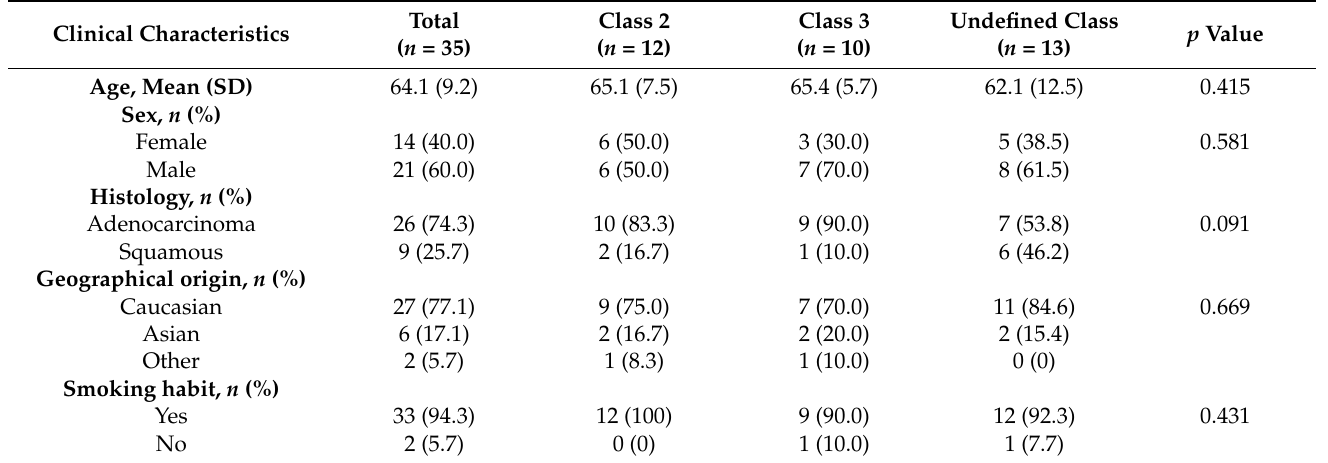
Table 2. Main clinical characteristics of patients harboring BRAF mutations in POPLAR/OAK cohort. Clinical